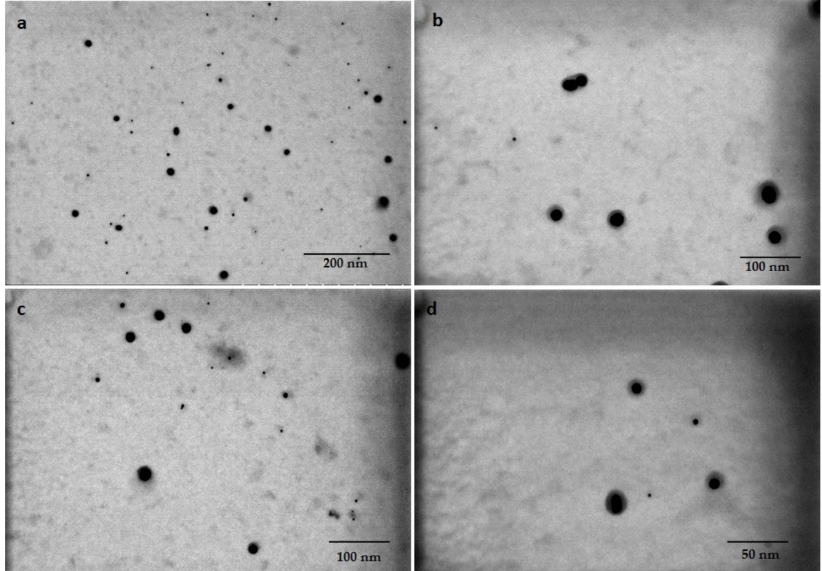
Figure 6. Spherical-shaped GNP synthesized by standard fucoxanthin ( a ) and extracted fucoxanthin ( b – d ) from N. shiloi